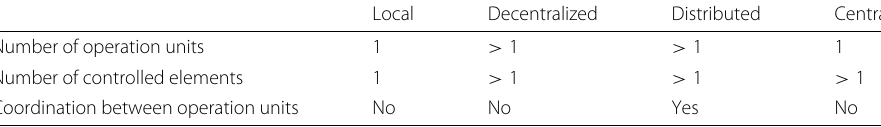
Table 1 Analysis of smart grid solutions according to the Assessment Classifiers Local Decentralized Distributed Central Number of operation units 1 > 1 > 1 1 Number of controlled elements 1 > 1 > 1 > 1 Coordination between operation units No No Yes